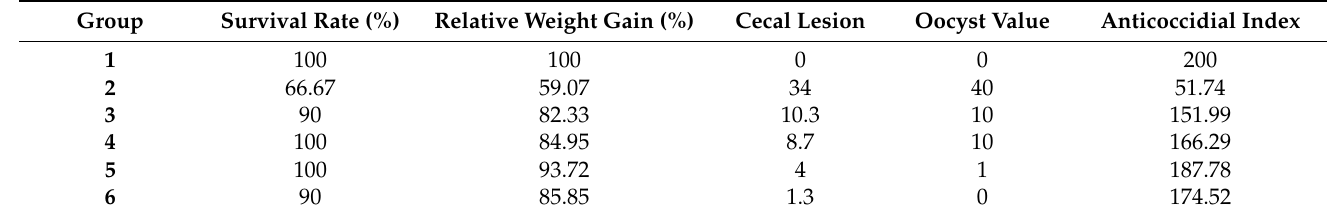
Table 3. Evaluation results of the anticoccidial index in each experimental group.